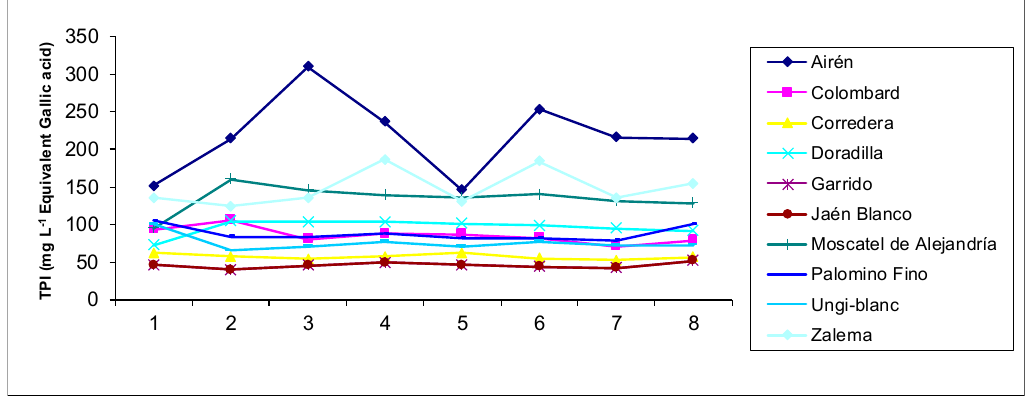
Figure 3. Evolution of the total polyphenol index (TPI) values in the aged distillates of the different